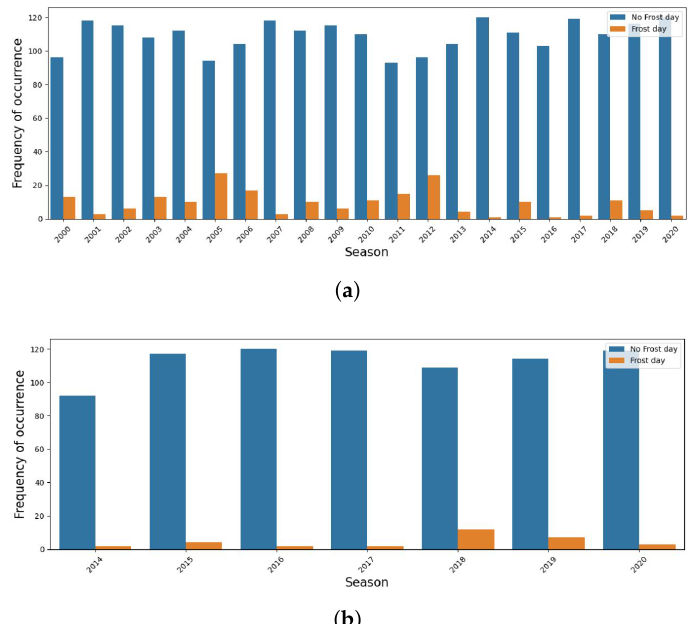
Figure 1. Distribution of frost days in Belgida and Carlet. Each season consists of December to March. ( a ) Carlet, ( b )